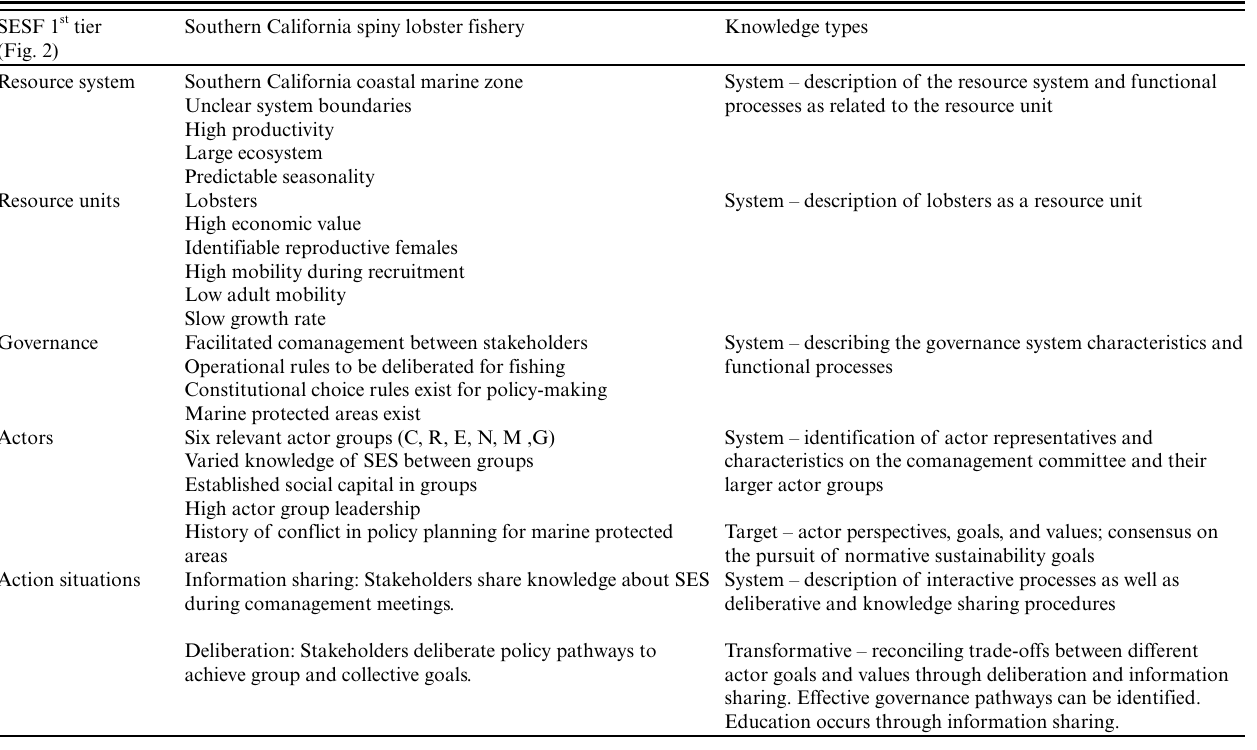
Table 3 . A demonstrative diagnosis of the Southern California spiny lobster fishery using the social-ecological systems framework (SESF). First tier subsystems from the SESF are shown (Fig. 2). Data from the fishery and the knowledge types developed are indicated. This table represents a subset of data taken from the full diagnosis of the fishery by Partelow and Boda (2015). Stakeholder groups: commercial (C), recreational (R), non-consumptive (N), environmental (E), marine science (M), and government (G).